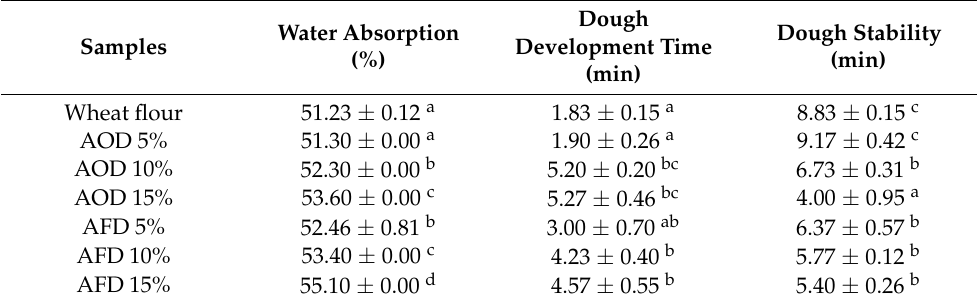
Table 2. Mixing characteristics of wheat flour enriched with cricket